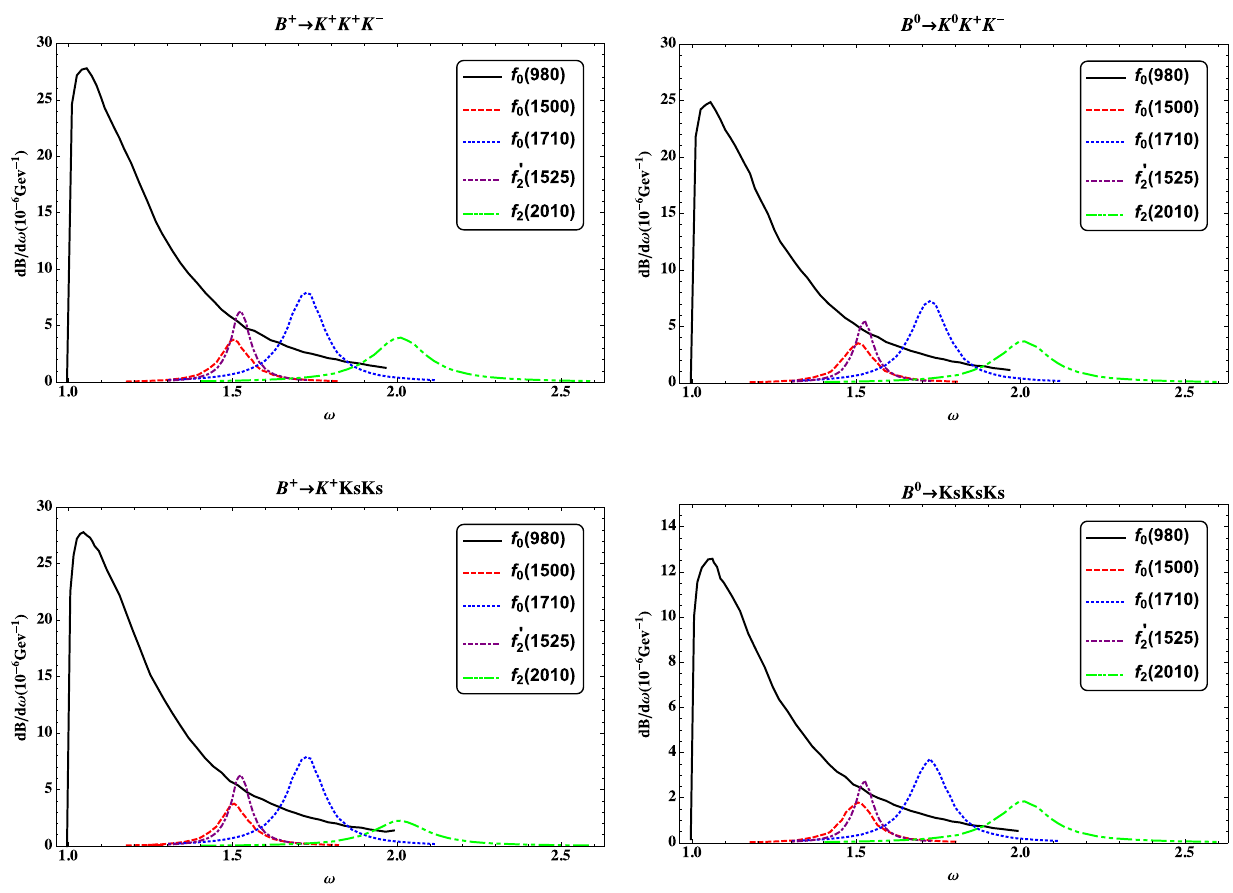
Fig. 3 The ω -dependence of differential branching fractions from f 0 ( 980 ) , f 0 ( 1500 ) , f 0 ( 1710 ) , f (cid:6)